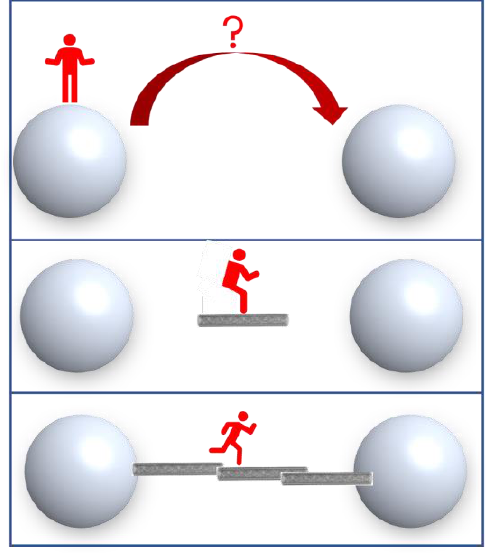
Figure 7. Mechanism diagram of thermal conductivity enhancement.